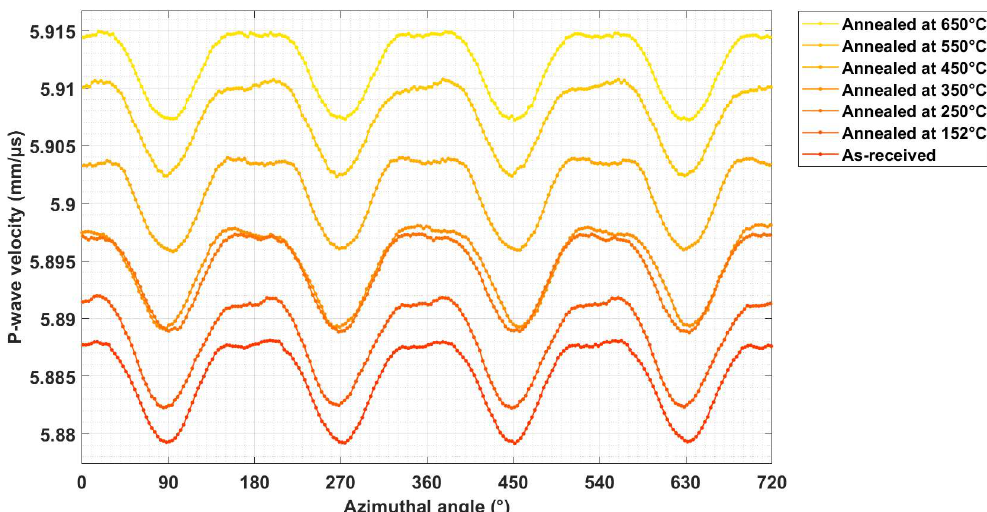
Figure 12. The measured longitudinal wave velocity as a function of azimuthal angle for the as received and tempered martensite materials.